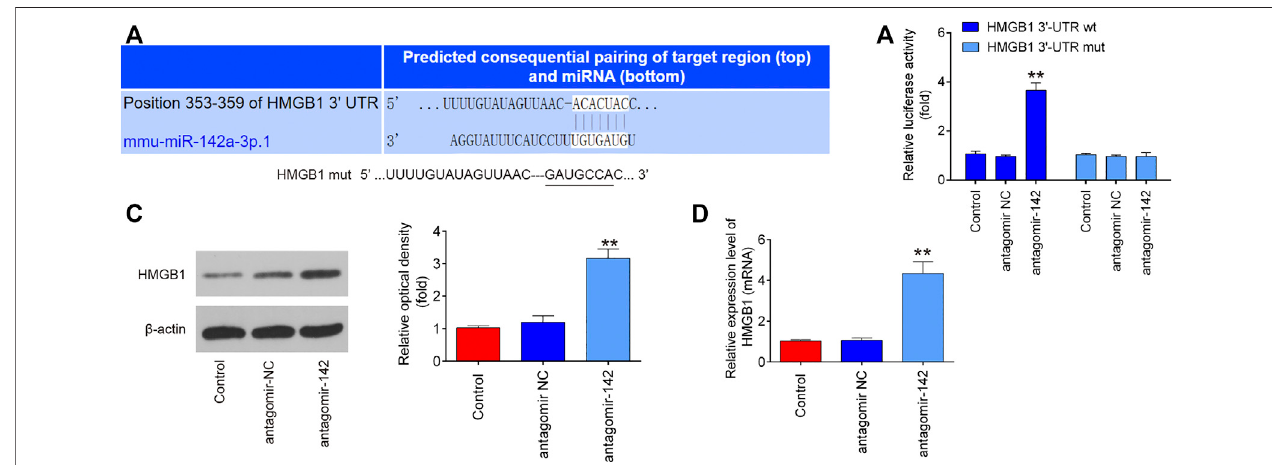
FIGURE 7 | HMGB1 is a direct target of miR-142. (A) miR-142-binding sequences in the 3 ′ -UTR of HMGB1 and mutated sites in 3 ′ -UTR of HMGB1. (B) The relative luciferase activity of HMGB1-2 wild type (wt) or mutant (mut) 3 ′ -UTR in BV-2 cells following transfection with antagomiR-142 and antagomiR NC as exhibited (n (cid:1) 3). (C and D) The protein and mRNA expressions of HMGB1 were detected by western blot and qRT-PCR after treatment with antagomiR-142 in BV-2 cells. All measurement data which were expressed as mean ± standard deviation and analyzed by one-way analysis of variance. ** p < 0.01 vs. antagomiR-NC group.